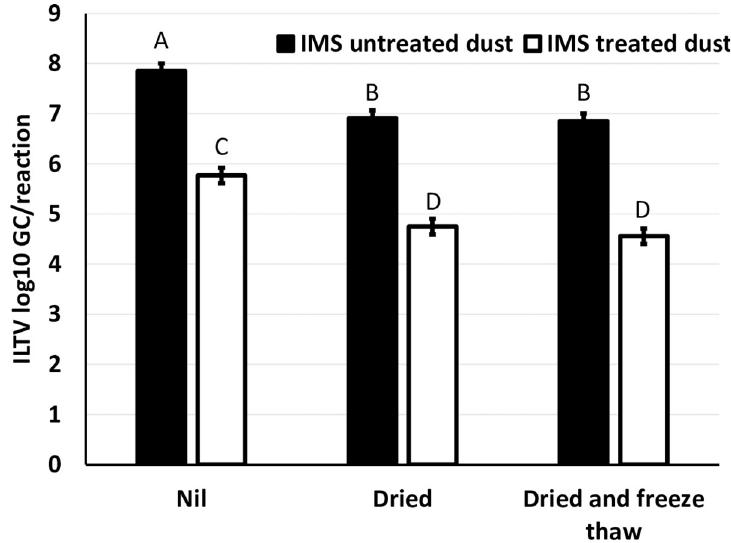
Fig 4. Effect of IMS pre-treatment on ILTV GC recovered from spiked dust samples subjected to three different treatments. Dust was spiked with ILTV at a concentration of 400 TCID 50 and either reconstituted in cell medium immediately (Nil) or dried at 30˚C for 24h (Dried) or dried and subjected to two freeze-thaw cycles (Dried and freeze- thaw). Superscripts ( ABC ) not sharing the same letter denote difference (p < 0.05) between samples.